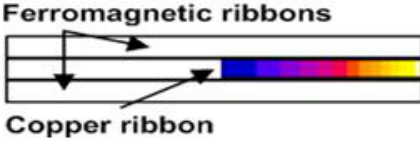
Figure 1. Current density distribution inside the middle half cross- section of a sandwich Ferro / Copper / Ferro at 1 MHz (blue to yellow corresponds to a ratio on the current density magnitude from 1 to 4).